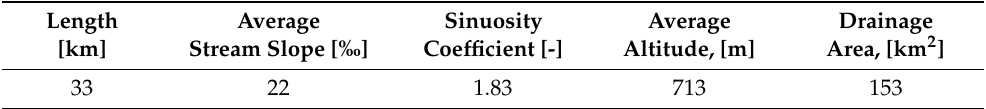
Table 2. The morphometric characteristics.